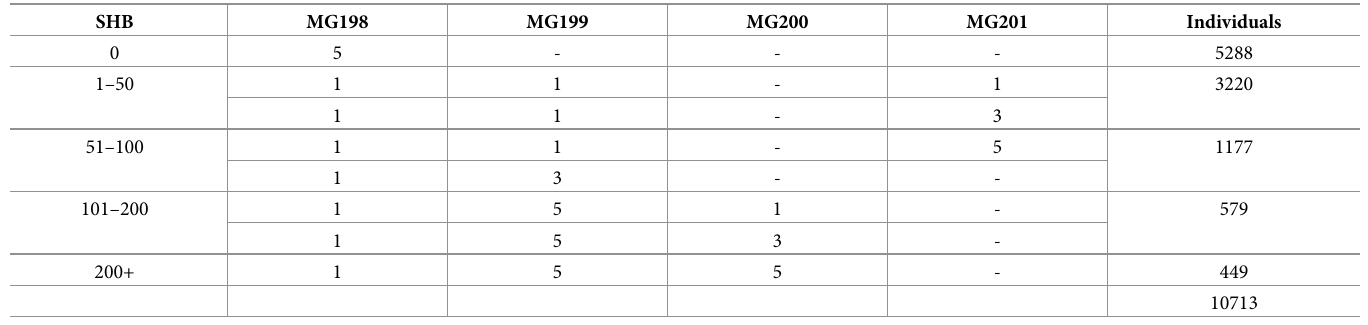
Table 4. SHB is based on the answers of four questions on the amount of time an individual spent on helping others during the previous year.